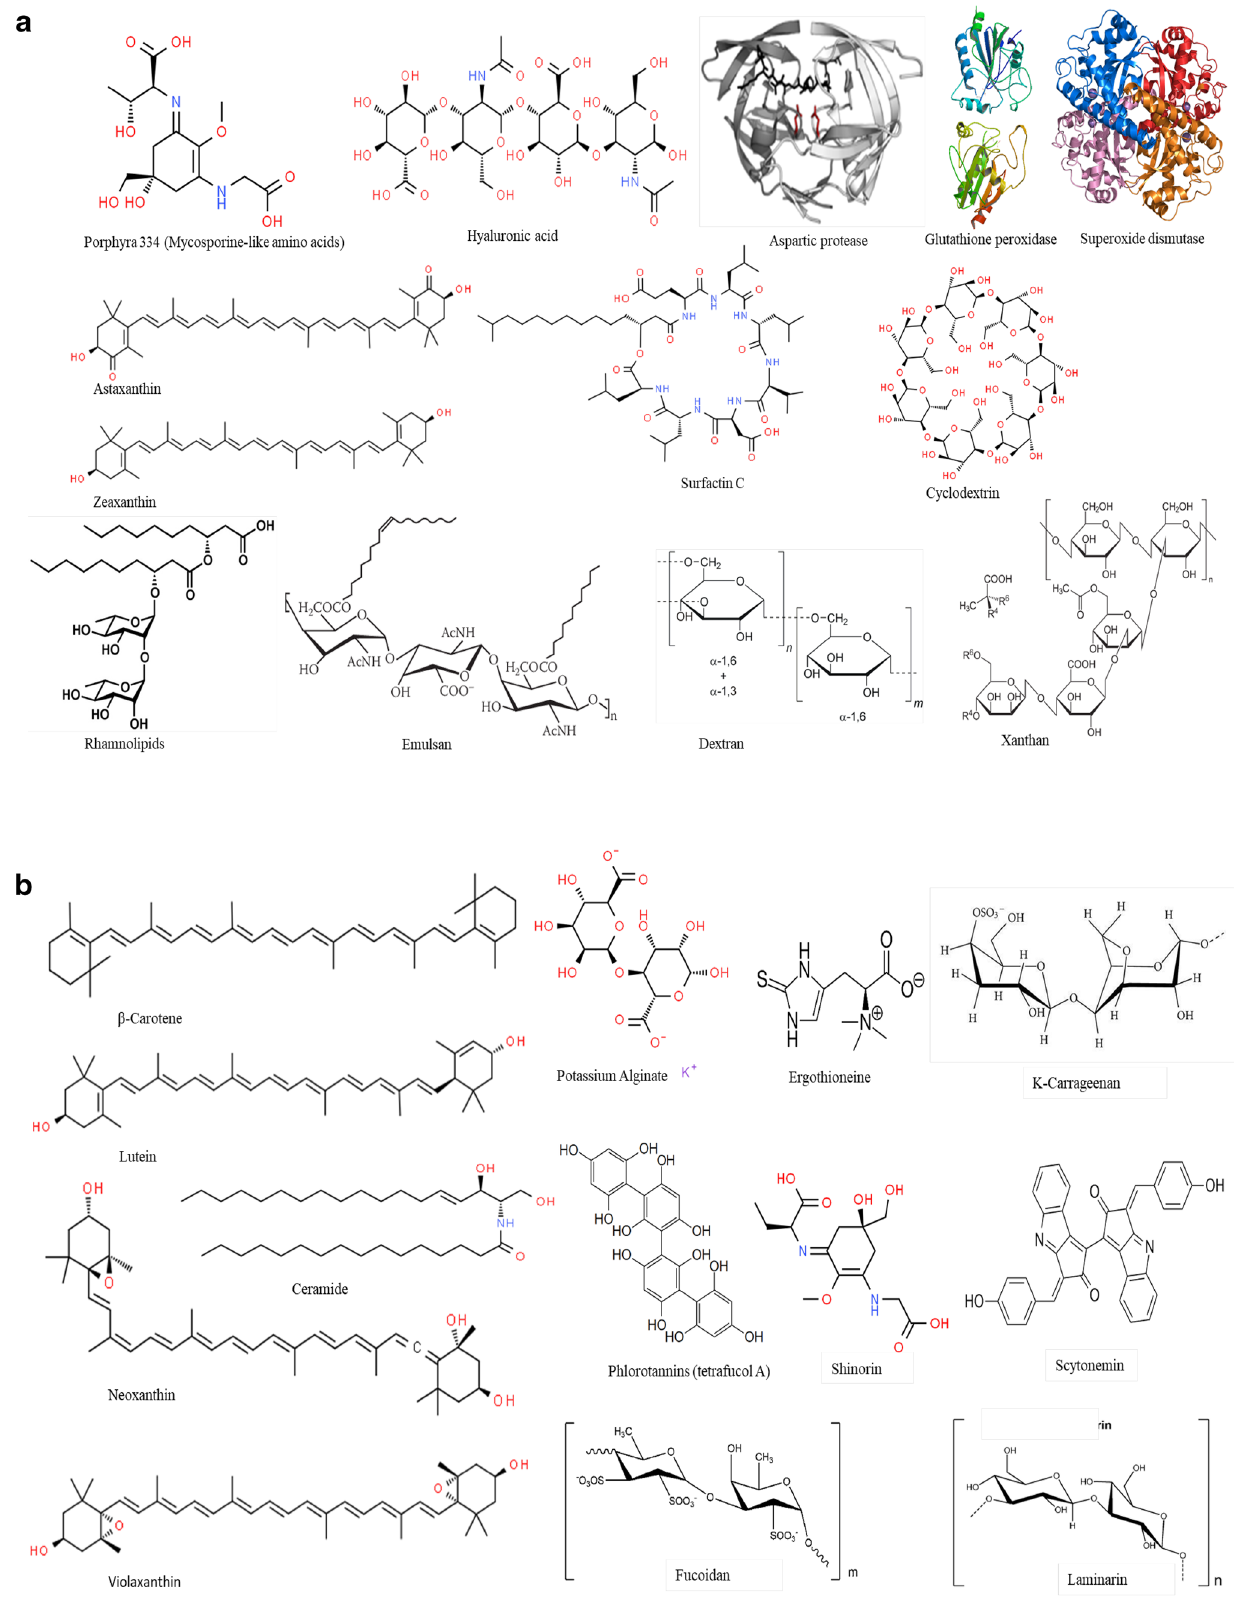
Fig. 2 Key structures of various compounds derived from microbial, fungal and algal sources used in cosmetics